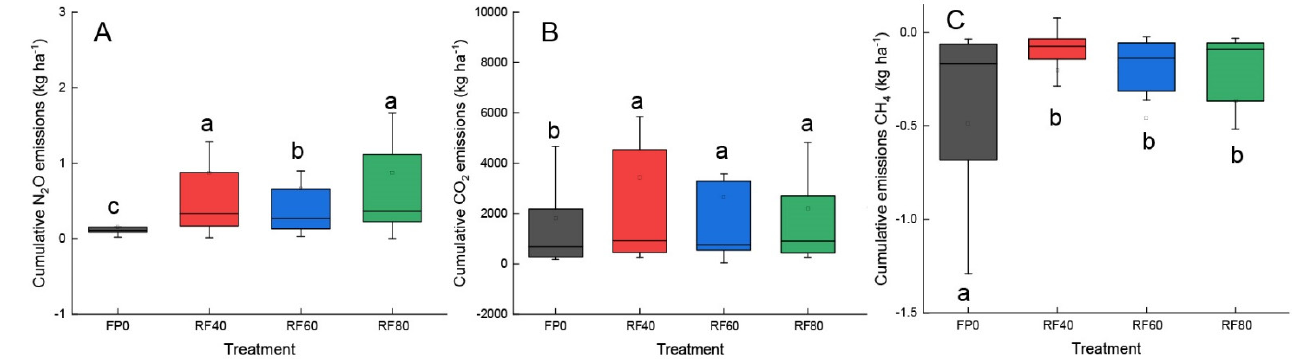
Figure 5. Cumulative emissions of N 2 O ( A ), CO 2 ( B ), and CH 4 ( C ) from the field during winter wheat growing seasons in 2017–2019. Same lowercase letters indicate data without significant differences at p < 0.05 level.